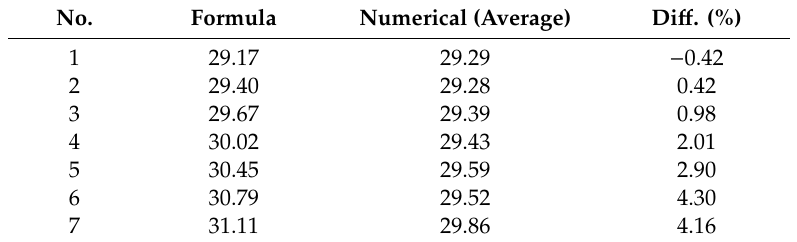
Table 7. Stress intensity factor comparison between empirical formula and finite element analysis